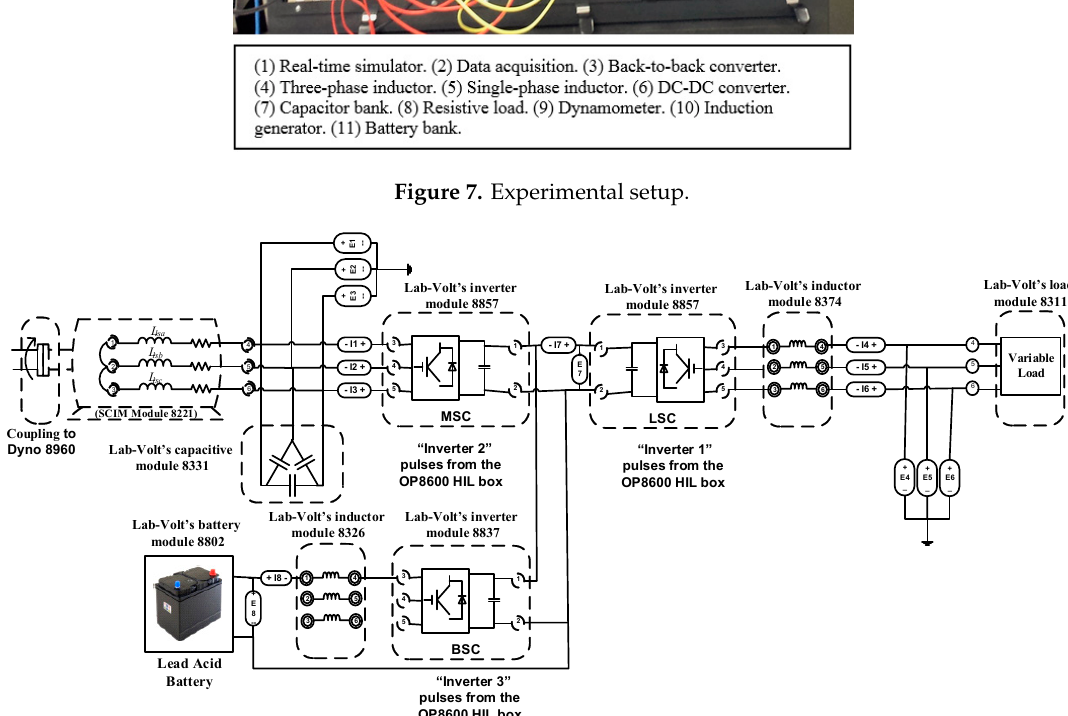
Figure 8. Connection schematic of the experimental setup. Table 1. Characteristics of the microgrid elements.